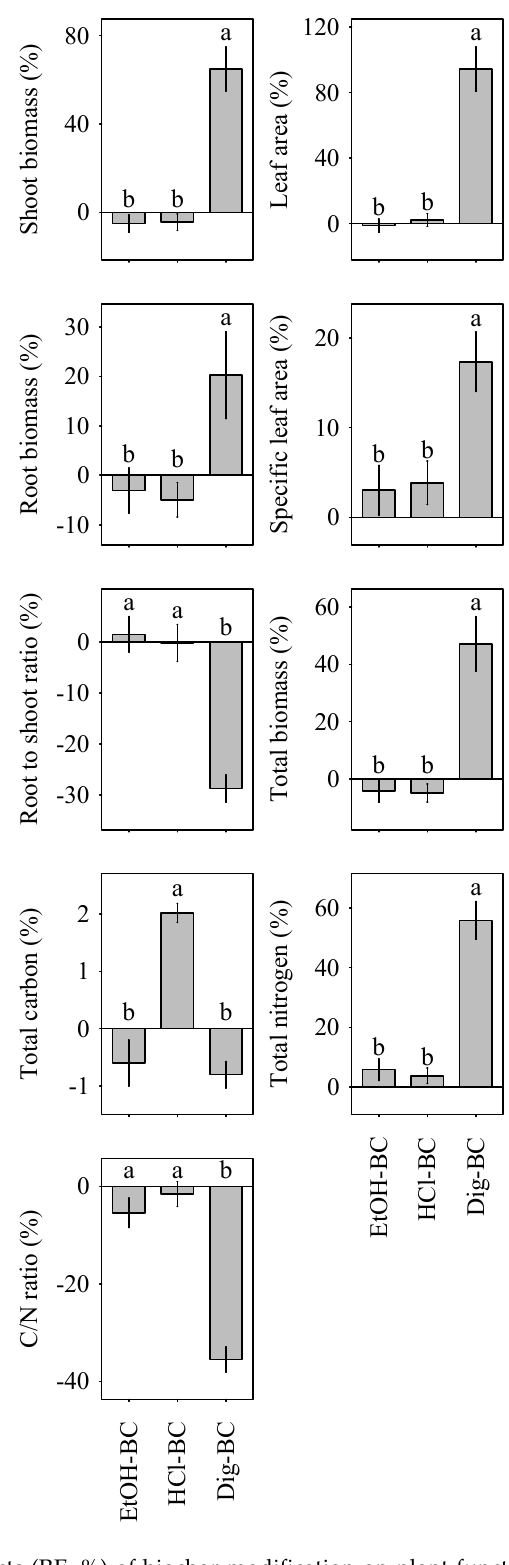
Figure 2. Relative effects (RE, %) of biochar modification on plant functional traits (i.e., leaf area, specific leaf area, root to shoot ratio, and biomass) and plant elemental concentrations (i.e., total carbon, total nitrogen) relative to the non-modified NM-BC. Different lower-case letters indicate significant differences ( p < 0.05) between biochar modification effects, namely EtOH-BC, HCl-BC, and Dig-BC. Data is shown as means with standard error ( n = 24).